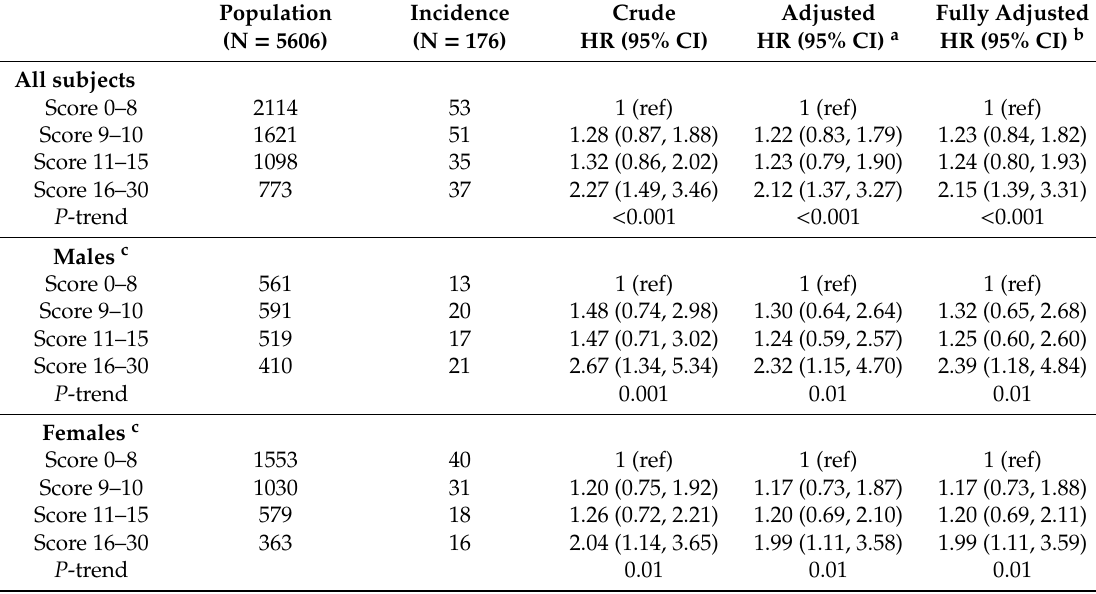
Table 5. Comorbidity scores and the risk of cancer